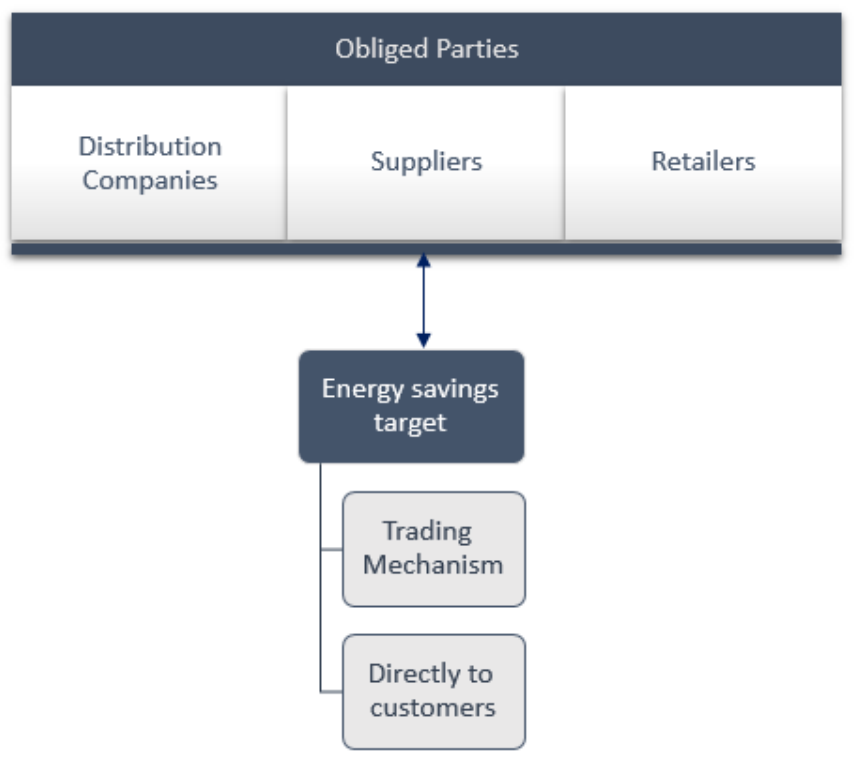
Figure 2. The mechanism of EEOs.